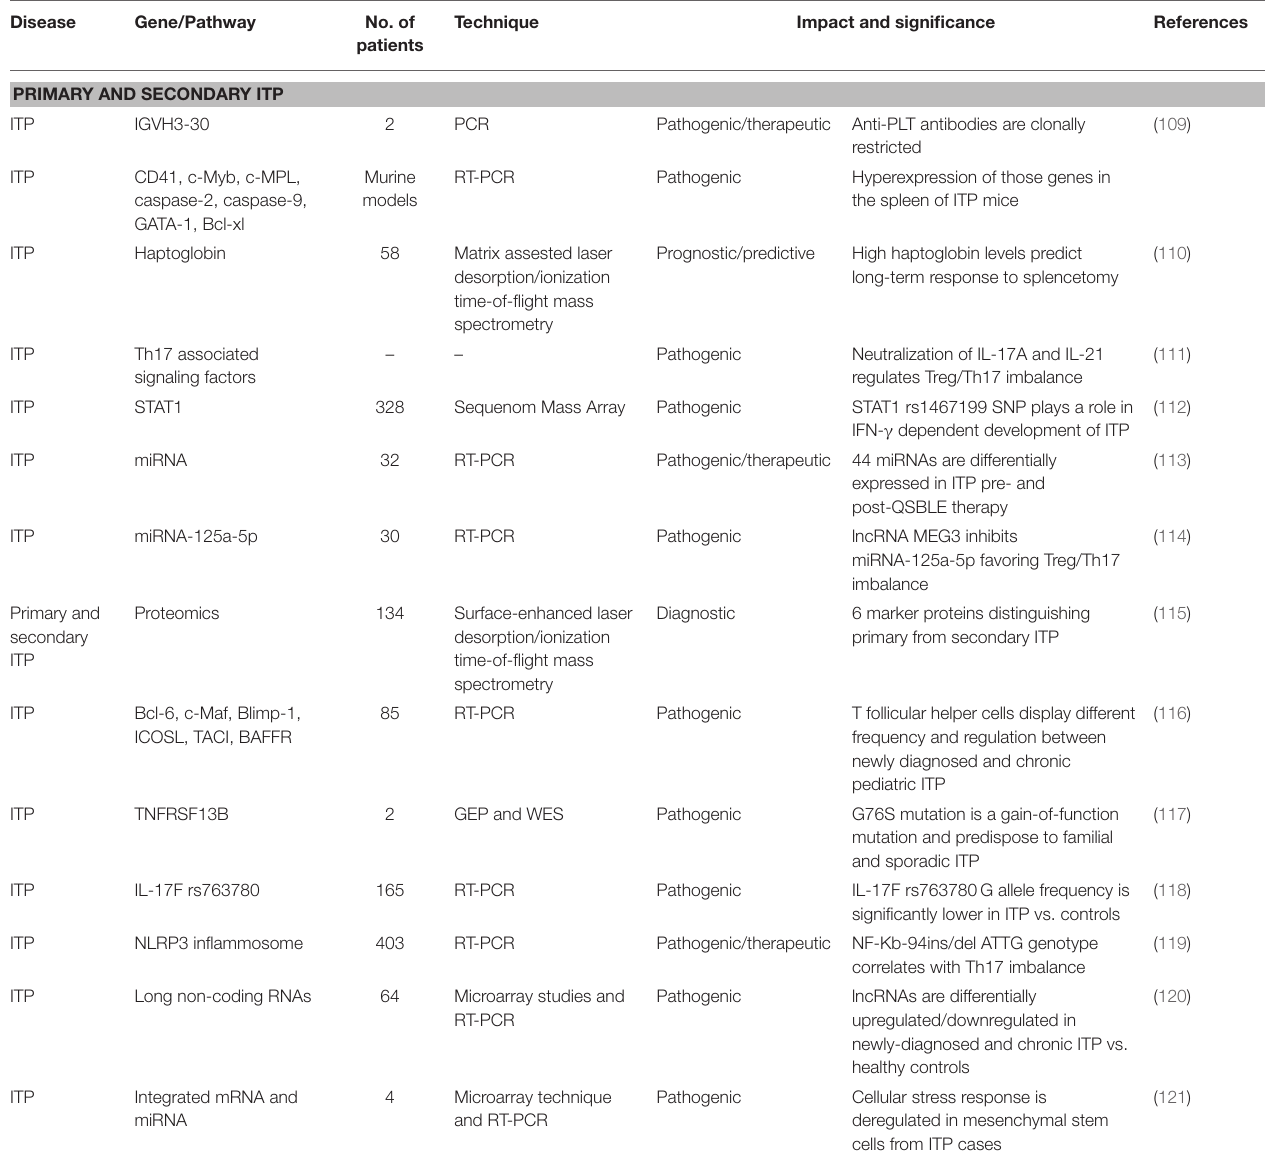
TABLE 3 | Molecular findings in primary and secondary immune thrombocytopenia (ITP).